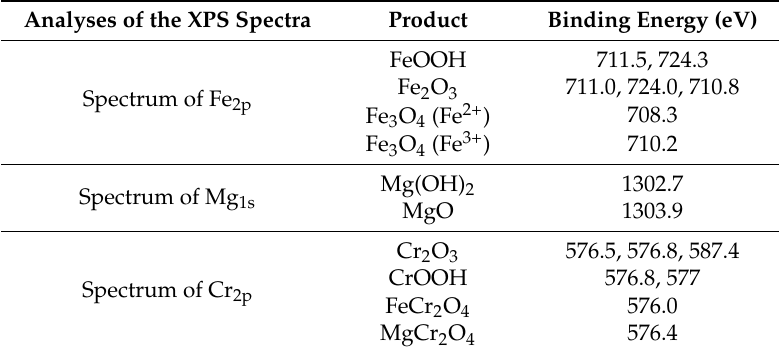
Table 2. Analysis of the XPS peaks for the surface of the specimens.